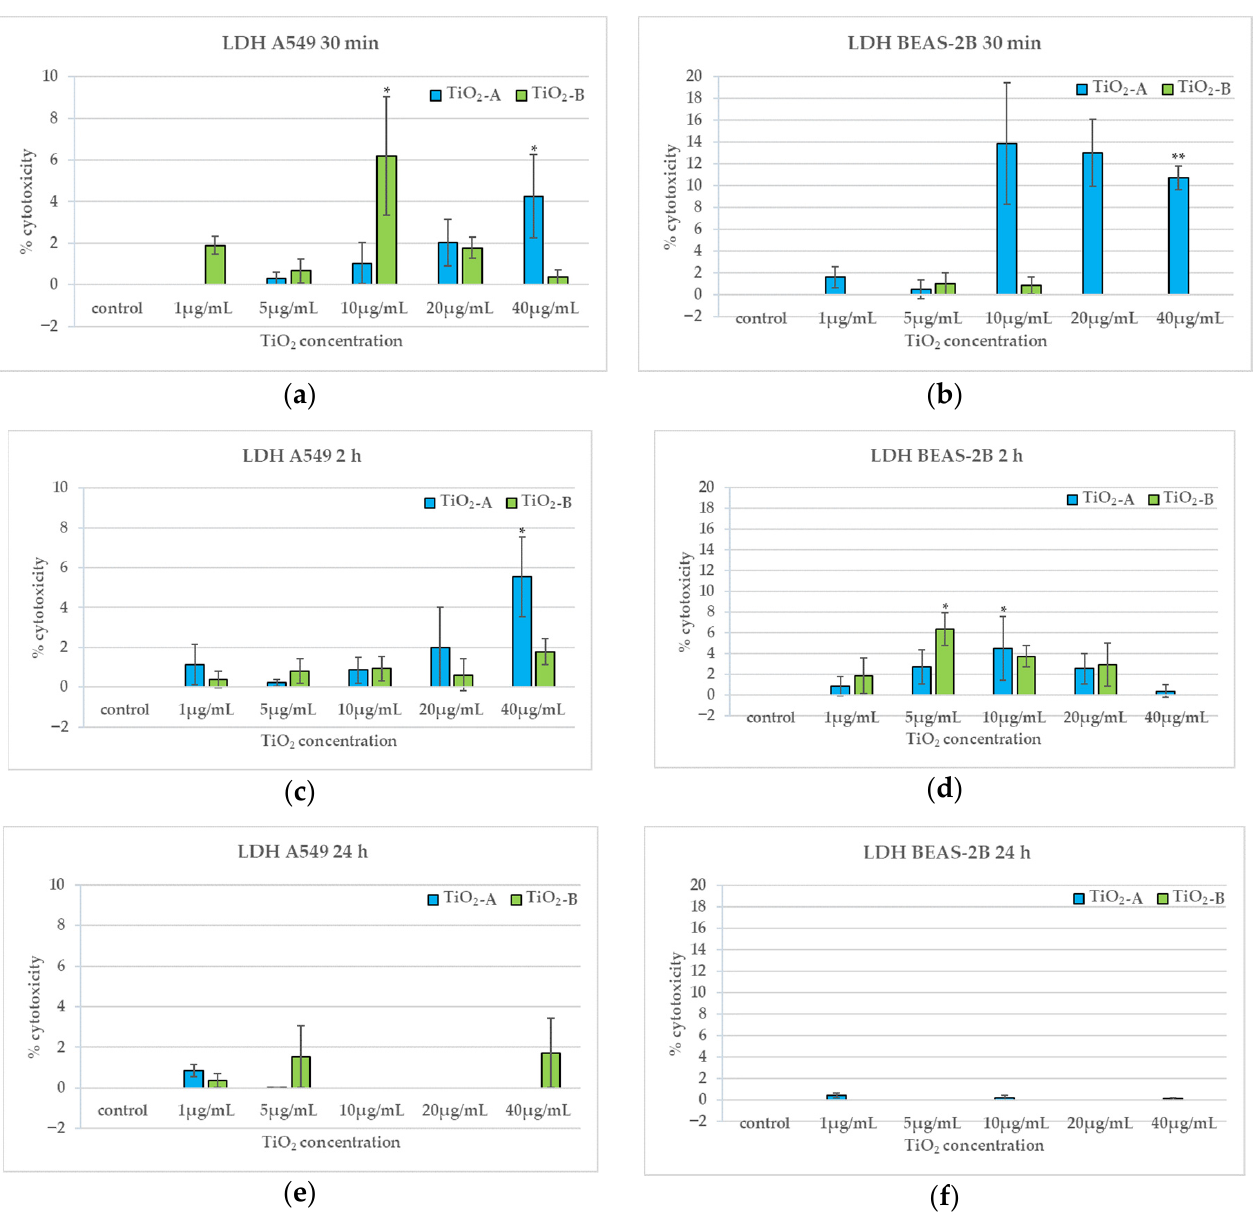
Figure 4. Lactate dehydrogenase (LDH) release expressed as a per cent of cytotoxicity in A549 and BEAS-2B cells after 30 min ( a , b ), 2 h ( c , d ) and 24 h ( e , f ) exposure to TiO 2 NPs. * p < 0.05, ** p < 0.01. Data relative to TiO 2 -A are previously published in [10] (Reproduced with permission from [10]. Copyright John Wiley & Sons, Ltd.,